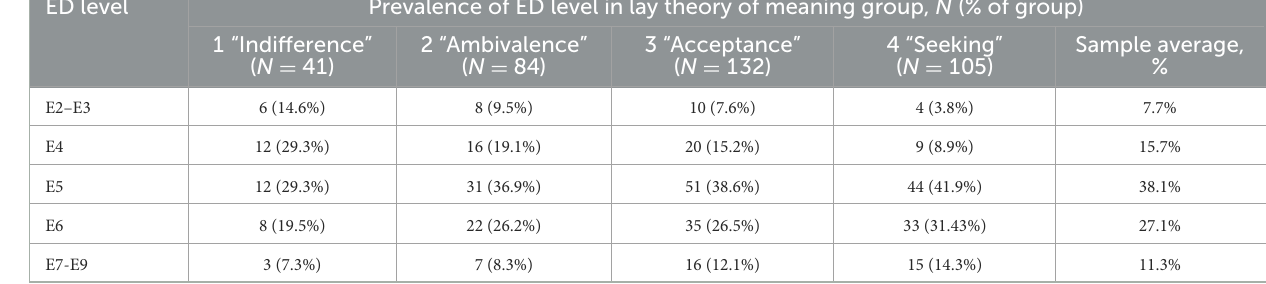
TABLE 4 Prevalence of individuals at different ED stages in each latent class.